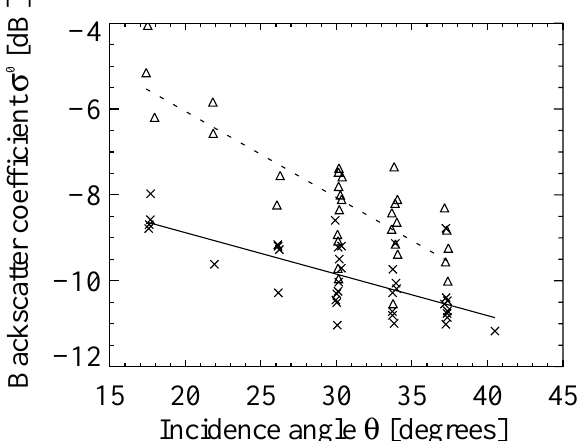
Fig. 9. Angular behaviour of ASAR backscatter for an arable land pixel. Crosses depict observations during summer months, trian- gles observations during winter months. Linear regression lines for summer and winter are in solid and dashed,